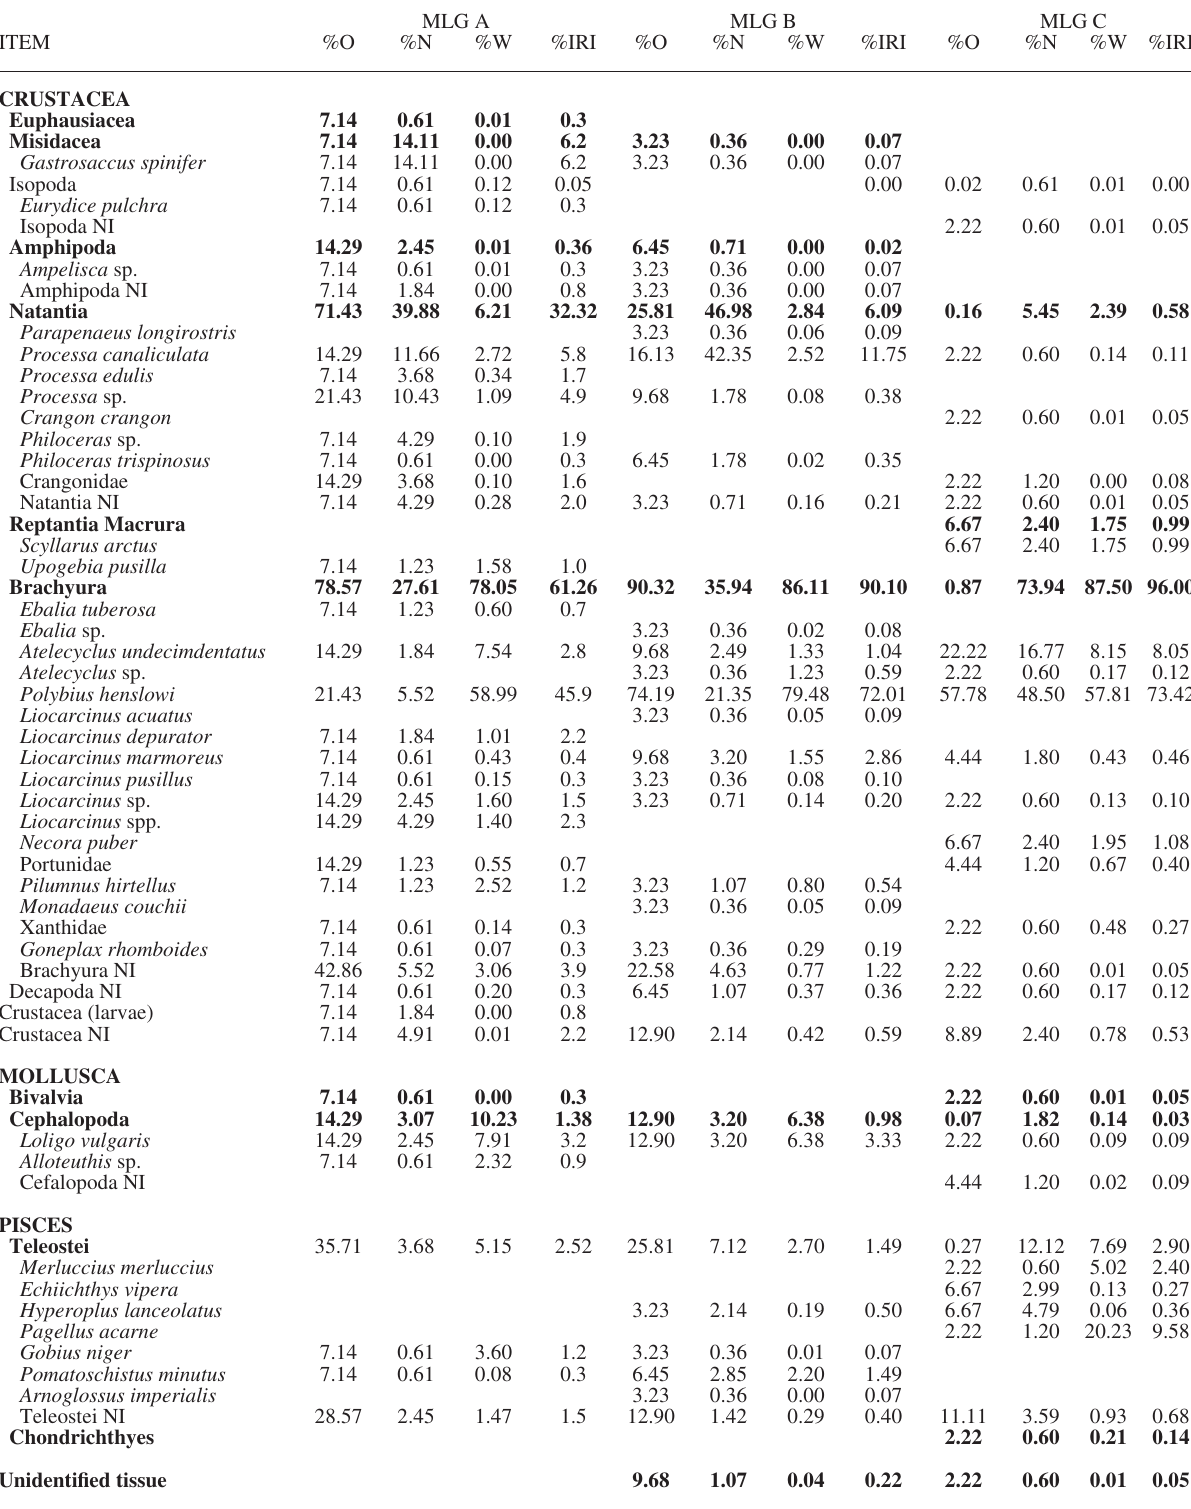
Table 3 . – S tomach contents of R. undulata expressed as frequency of occurrence (%o), percentage by number (%n), percentage by weight (%W) and percent index of relative importance (%IrI) for each major length group (MLg) (a: 200-550 mm; B: 550-750 mm and C: 750-1000 mm). subtotals are presented in bold for higher taxonomic levels.